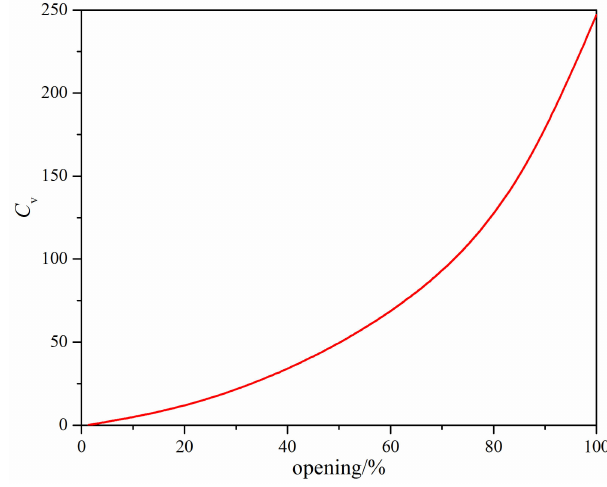
Figure 5. Flow characteristics of the original V-ball valve.